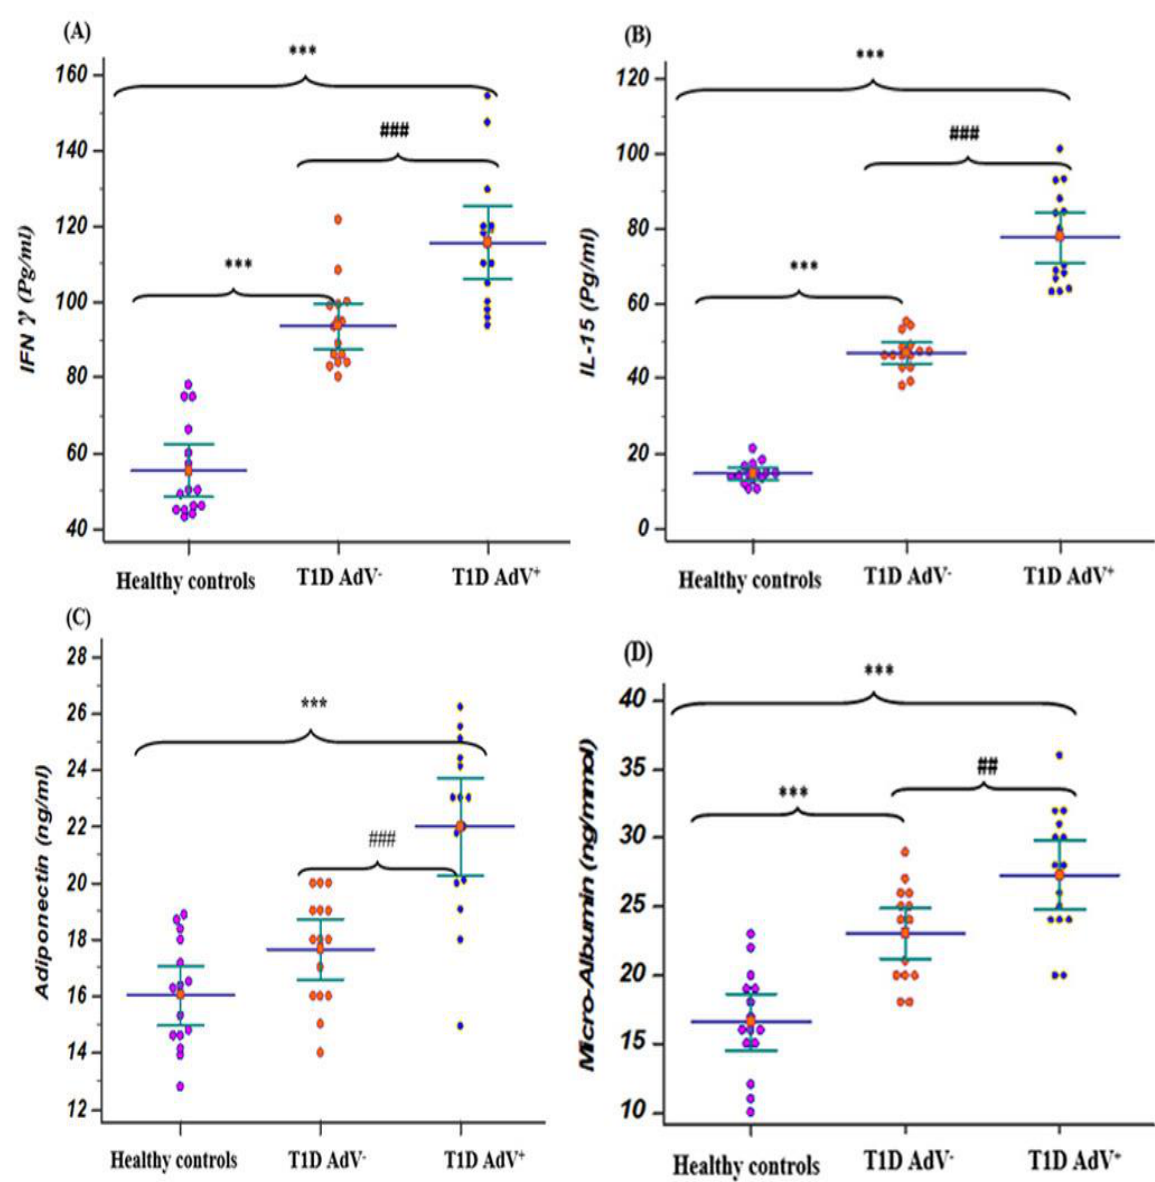
Figure 2. Levels of IFN γ , IL-15, adiponectin, and microalbuminuria in the T1D—negative AdV (PCR and antibodies) and T1D—AdV positive (PCR) groups in comparison to healthy control. ( A ) IFN γ : control group: mean 55.26 ± 3.2 and range 43–78; T1D AdV − : mean 93.55 ± 2.86 and range 80–121.5; and T1D AdV + : mean 115.7 ± 4.57 and range 93–154.4; ( B ) IL-15: control group: mean 14.48 ± 0.73 and range 10.3–21.2; T1D AdV − : mean 46.6 ± 1.25 and range 38–55; and T1D AdV + : mean 77.64 ± 3.2 and range 63–101; ( C ) adiponectin: control group: mean 14.75 ± 0.36 and range 13.8–19; T1D Adv − : mean 17.82 ± 0.417 and range 14–20.5; and T1D Adv + : mean 23.08 ± 0.47 and range 15.2–27; and ( D ) microalbuminuria: control group: mean 15.6 ± 0.97 and range 9–24; T1D Adv − : mean 24.83 ± 2.09 and range 17.4–29; and T1D Adv + : mean 29.1 ± 2.9 and range 21–36.6. Values were considered significantly different at *** p < 0.001 versus healthy controls, and ### p < 0.001 T1D—AdV − versus T1D—AdV + children. Type 1 diabetes parameters and